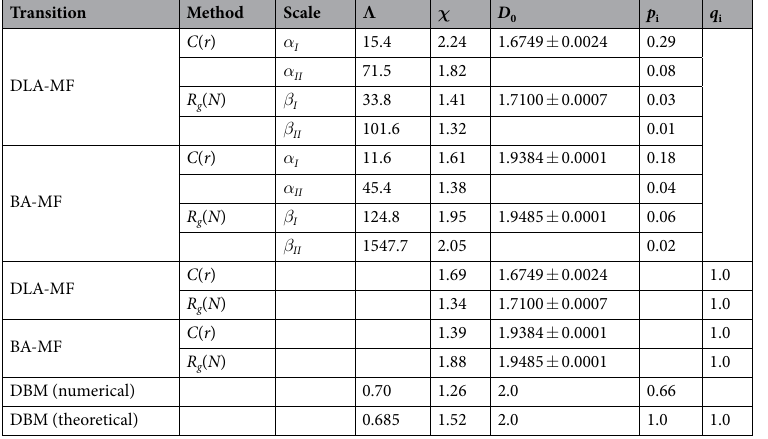
Table 2. Descriptions based on D ( p ) and D ( q ). First section: parameter values used to describe D ( p , Λ , χ ), using equations (2) and (3). In order to determine the inflection points, χ χ Λ = − χ D p ( / ) ( 1)/ for the 0 i for those obtained through R g ( N ). measurements obtained through C ( r ), while χ χ Λ = − + χ D p ( / ) ( 1)/( 1) 0 i Second section: equations (2) and (3), as function of q = p / p i , are used to fit the data for D ( q , χ ) obtained through C ( r ) and R g ( N ), respectively. In this description, only χ is remains as a fitting parameter and, by construction, all the inflection points are located at q i = 1. Third section: results for the DBM obtained through equation